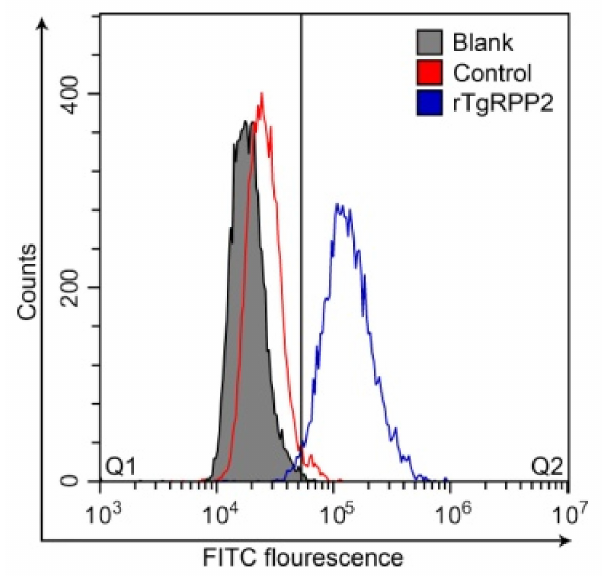
Figure 2. Flow cytometric analysis of rTgRPP2 binding to murine Ana-1 macrophages. In the blank and control groups, the Ana-1 cells were treated with phosphate-buffered solution (PBS) and pET32a vector protein (20 µ g/mL), while the experimental group was treated with purified recombinant TgRPP2 (20 µ g/mL; n =